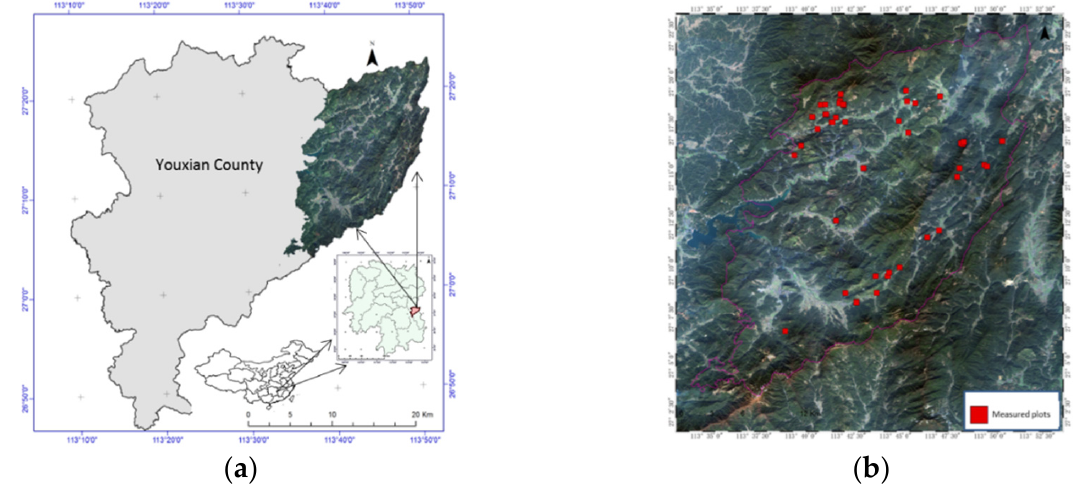
Figure 1. ( a ) Location of the study area; and ( b ) distribution of the ground measured plots (red squares) in the study area.